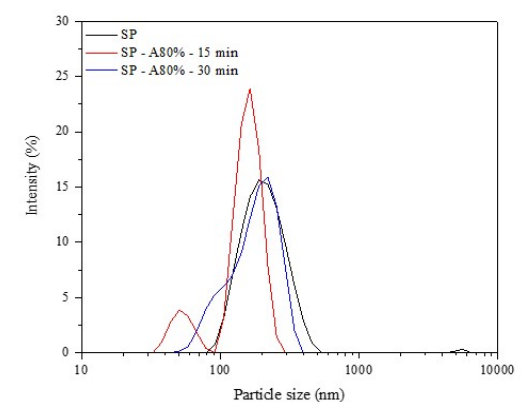
Figure 4. Size distribution of SP, SP - A80% - 15 min, and SP - A80% - 30 min aqueous dispersions, determined by